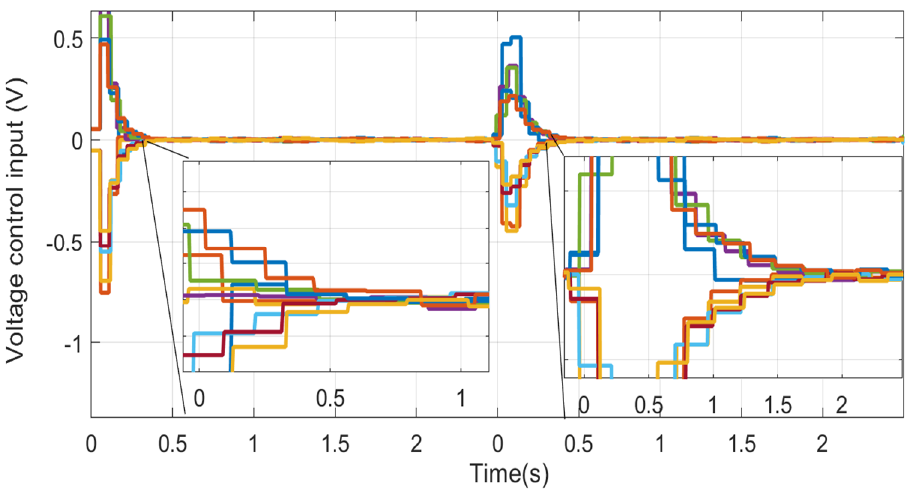
Figure 8. Control input with ETCP